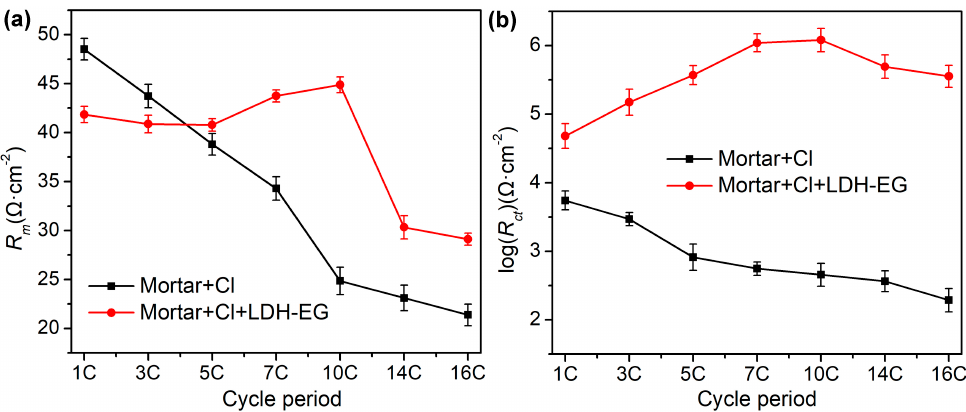
Figure 12. The time-dependent behavior of R m and R ct : ( a ) R m variation with time of steel-mortar electrodes, ( b ) R ct variation with time of steel-mortar